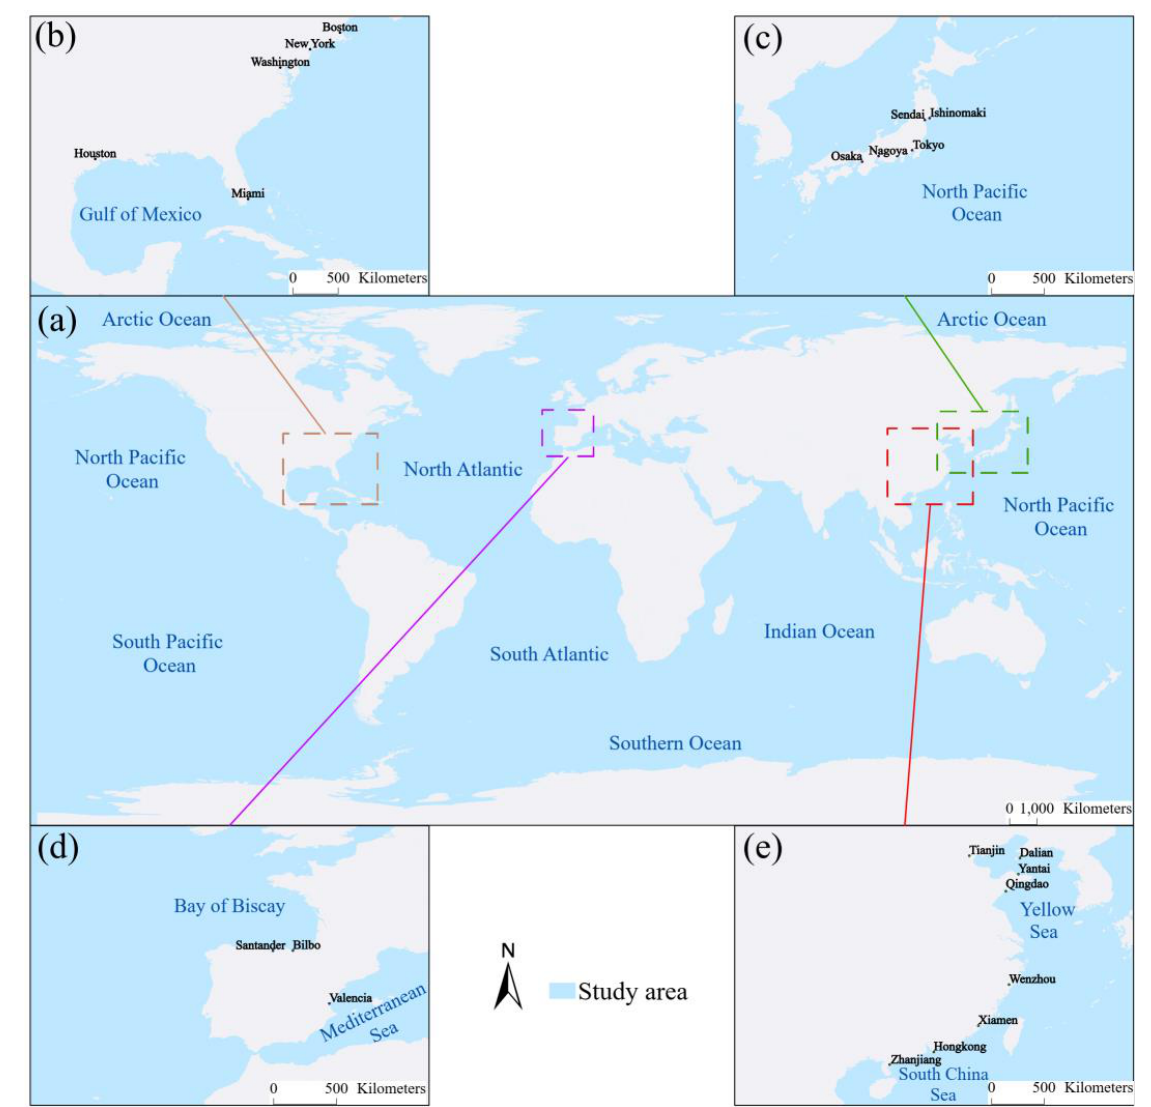
Figure 1. Study areas: ( a ) global ocean area; ( b ) United States of America offshore; ( c ) Japan offshore; ( d ) Spain offshore; ( e ) China offshore. Locations on the maps are referred to in the main text.